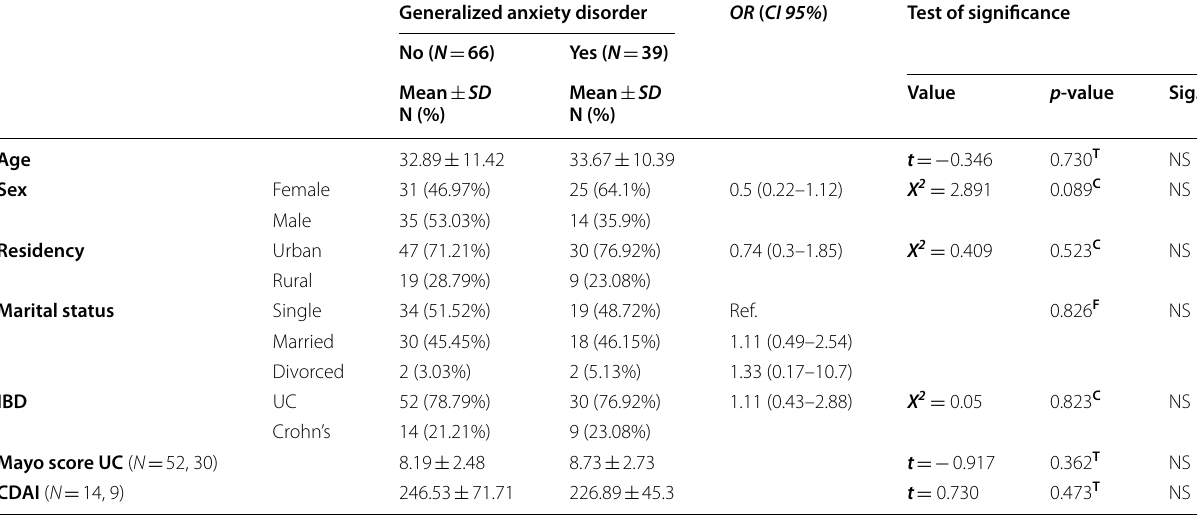
Table 5 Multivariate logistic regression analysis of the relationship between demographic and pathological characteristics of patients and existence of generalized anxiety disorder